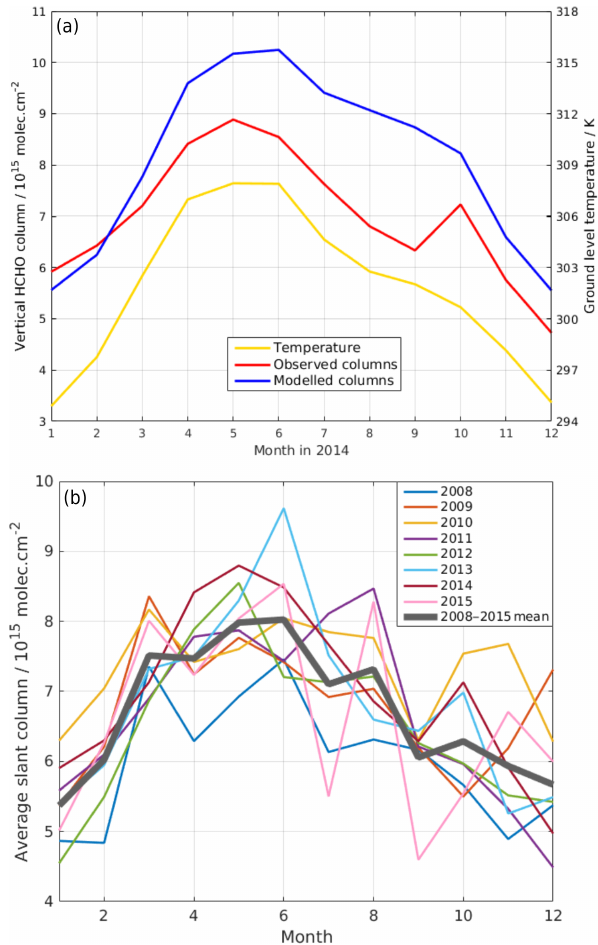
Figure 7. Time series of (a) OMI and GEOS-Chem vertical columns (10 15 moleccm − 2 ) for 2014, and (b) OMI slant columns (10 15 moleccm − 2 ) from 2008 to 2015 over India. GEOS-FP ground-level temperature (K) is also shown in the top panel. The thick grey line in the bottom panel denotes 2008–2015 HCHO col- umn monthly means.